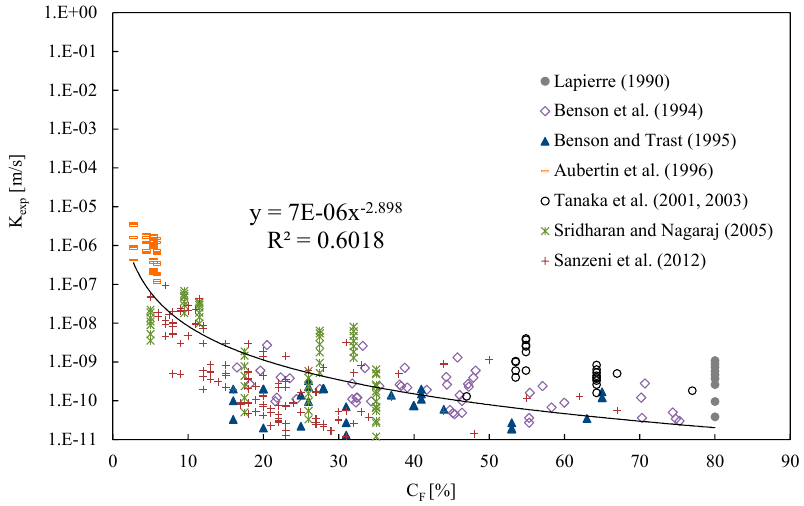
Figure 5. Experimental ( K exp ) and predicted value ( K pre ) of the saturated hydraulic conductivity as determined by Equation (22).